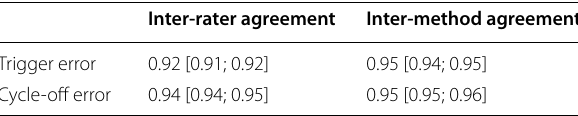
Inter-rater and method agreements as the intra-class correlation coefficient with a 95%